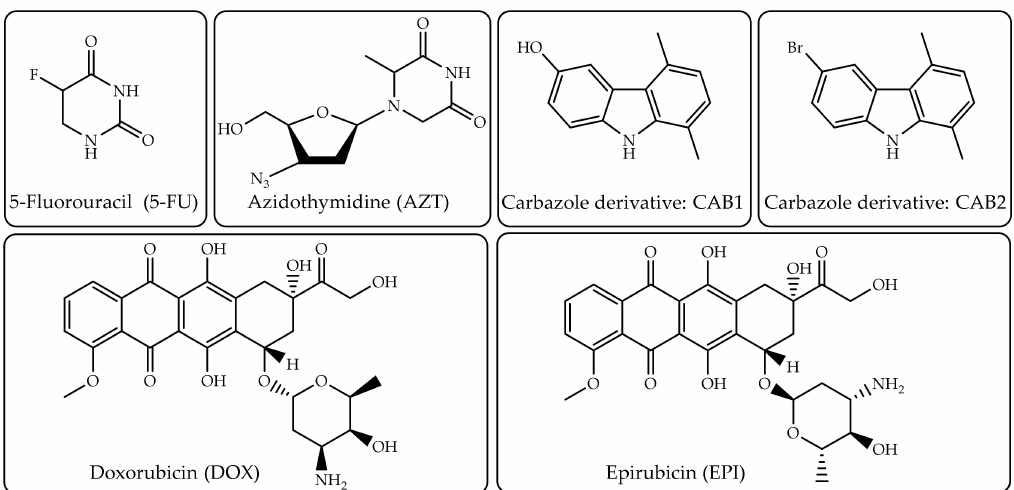
Figure 2. Structures of anticancer drugs applied for drug delivery by magnetic molecularly imprinted polymers (MMIPs) systems discussed in this review and published so